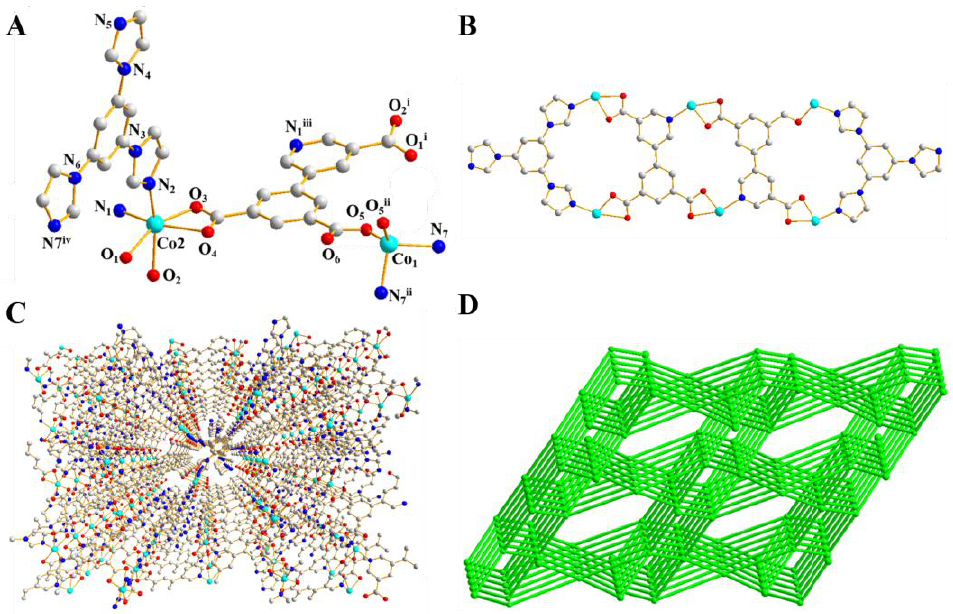
Figure 1. ( A ) The coordination environment of two Co(II) ions; ( B ) coplanar structure with two 21-membered-rings and one 18-membered-ring; and ( C , D ) the 3D structure and simplified 4-connected Wei topology of 1 .